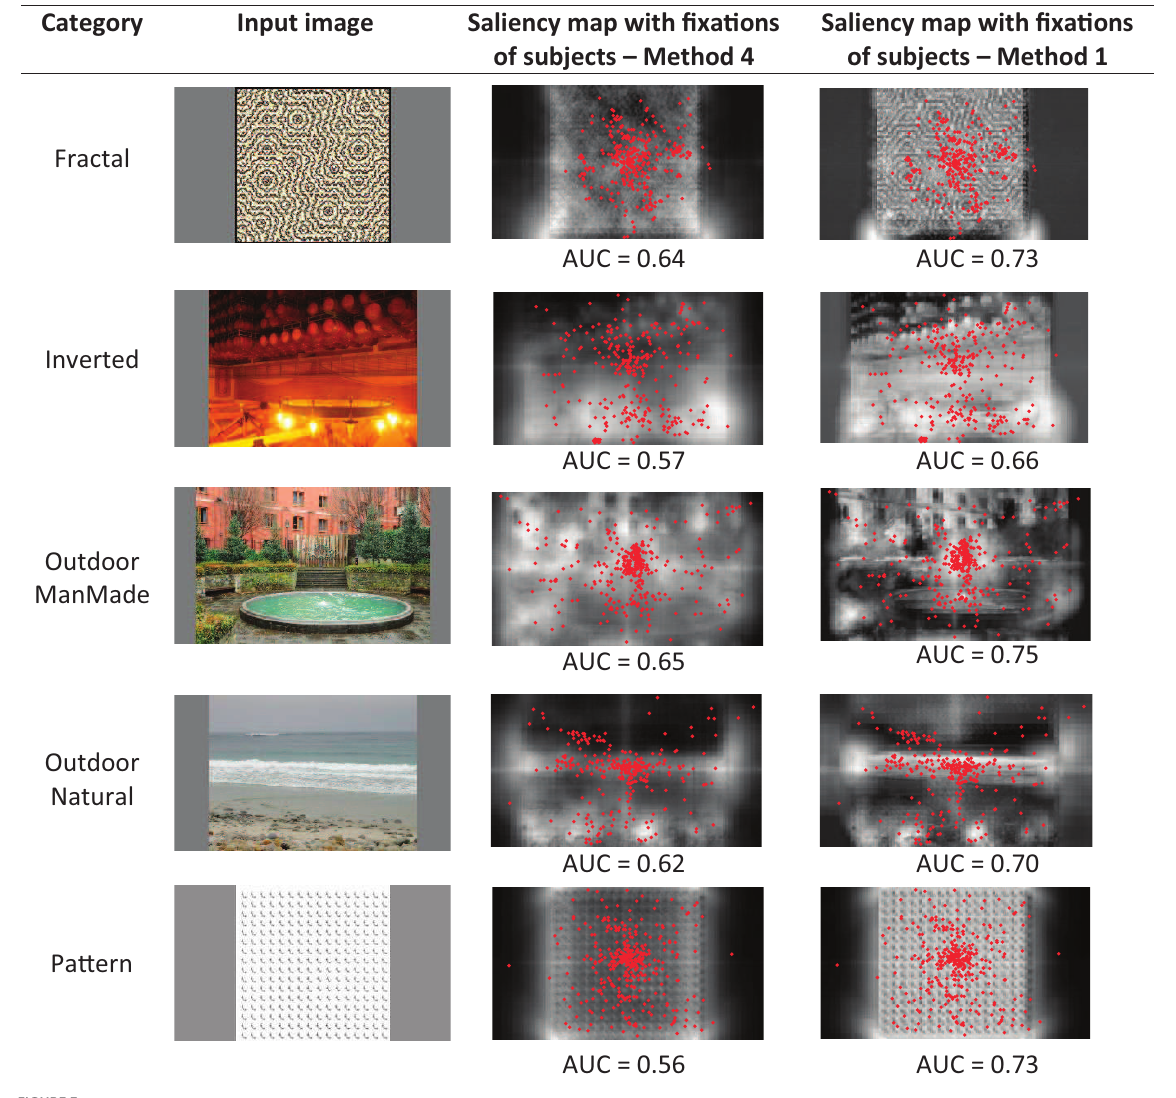
FIGURE3 Showing some out of the common images where the first method of obtaining the saliency map is better than the fourth method described in Section Layer V-obtaining saliency map because the conspicuity maps of particular features dominate the other features. The results are shown for the case of applying six center-surround difference maps for each